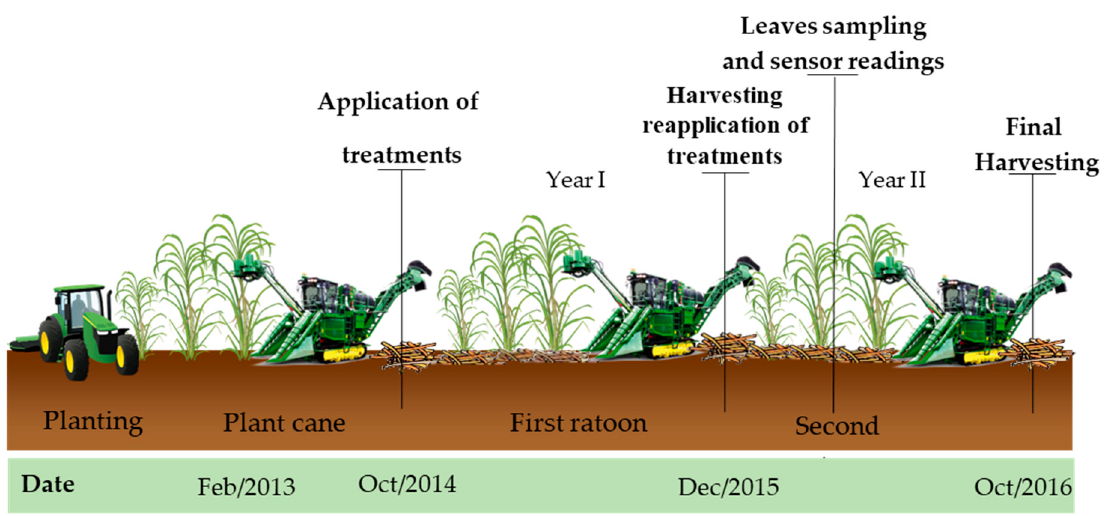
Figure 3. Timeline of the experiments establishment (at harvesting) and conduction over two years in southeast of Brazil. Source: adapted from Lisboa et al. [19].